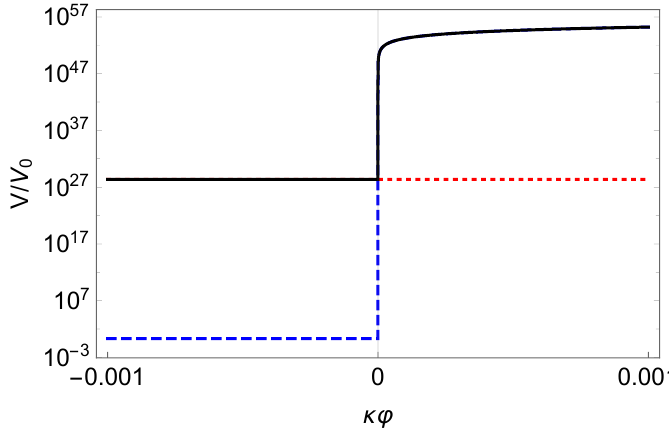
Figure 2 . The e(cid:11)ective potential in the BBN epoch (black solid line), which is the sum of the original potential (blue dashed line) and the matter contribution (red dotted line), with (cid:0) T (cid:22) (BBN) (cid:24) 10 29 (cid:26) (cid:3) (cid:22)